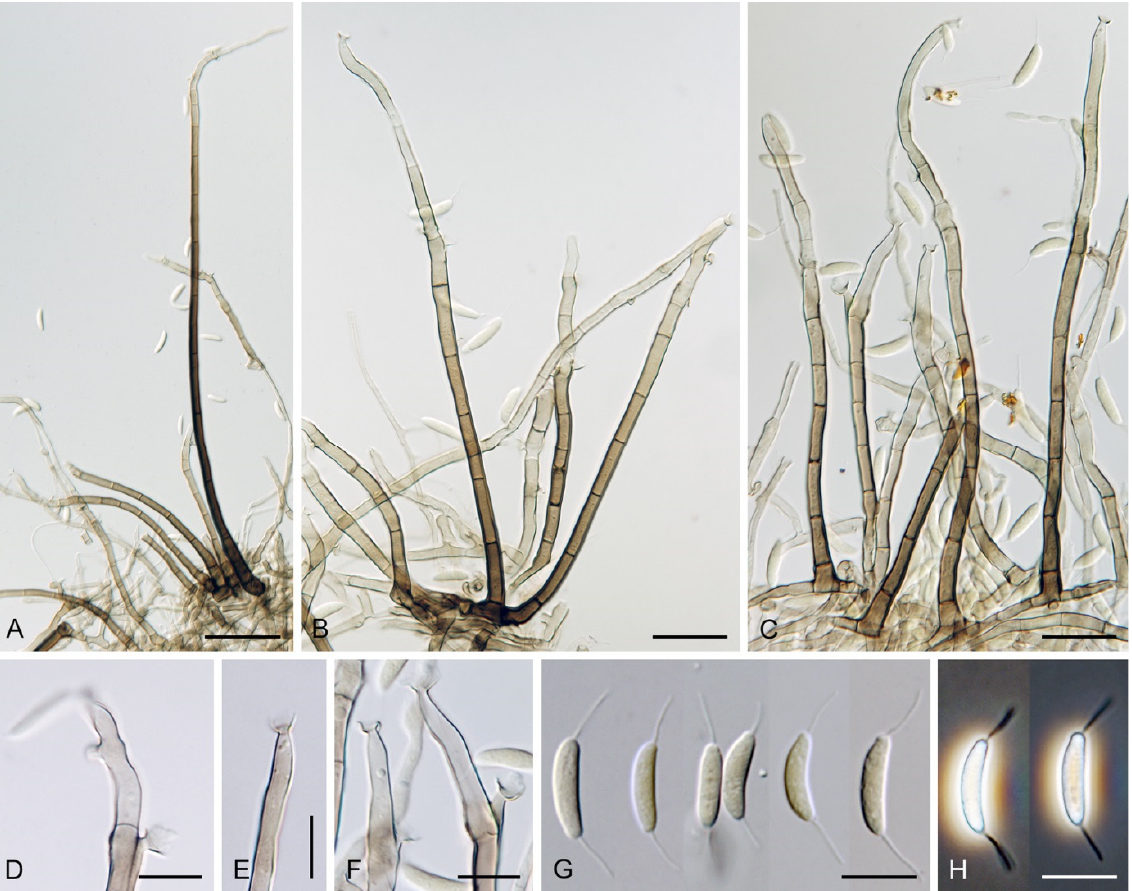
Figure 20. Codinaea siamensis (CBS 194.96). ( A , B ) Setae with conidiophores ( C ) conidiophores ( D – F ) conidiogenous cells with collarettes ( G , H ) conidia. Images: ( A – H ) on MLA after 6 weeks. Scale bars: ( A ) 50 μ m; ( B , C ) 20 μ m; ( D – H ) 10 μ m.